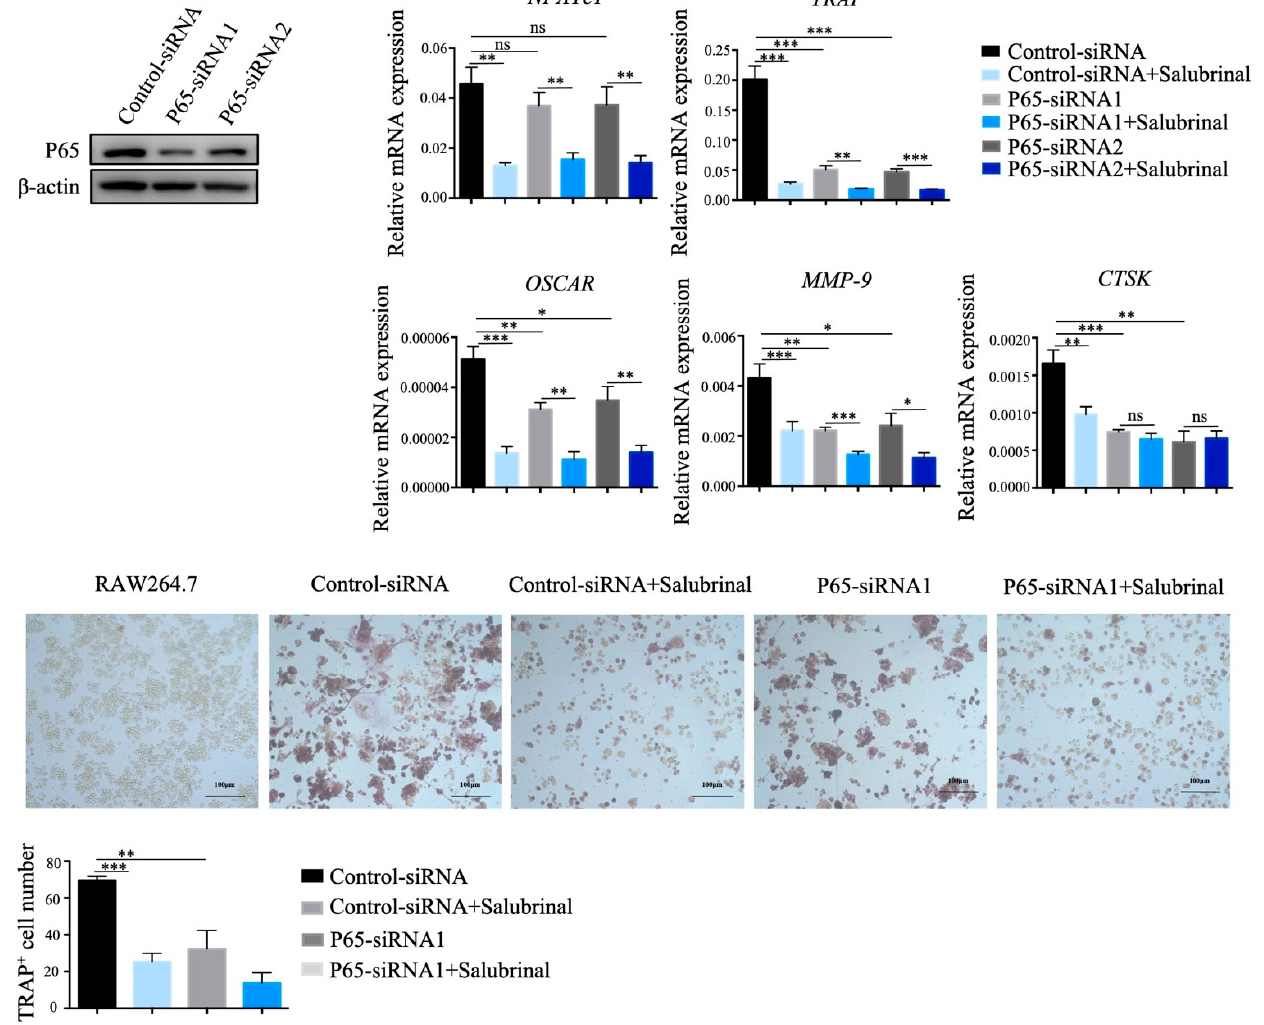
Figure 4. Salubrinal inhibited osteoclast formation by downregulating P65. We transfected specific P65-siRNA in RAW264.7 cells by using Attractene Transfection Reagent to knockdown of P65. ( A ) P65 abundance in RAW264.7 cells after P65 knockdown. ( B ) mRNA expression levels of NFATc1 , OSCAR , TRAP , MMP-9 , and CTSK gene were detected by qPCR after induction by RANKL (100 ng/mL) for 24 h, Salubrinal (10 µM) was added together with RANKL for 24 h. ( C ) Osteoclast numbers were quantified by TRAP staining after induction by RANKL (100 ng/mL) for 4 days, Salubrinal (10 µM) was added for the last 3 days. Data are shown as means ± SEM. * p < 0.05, ** p < 0.01, *** p < 0.001.